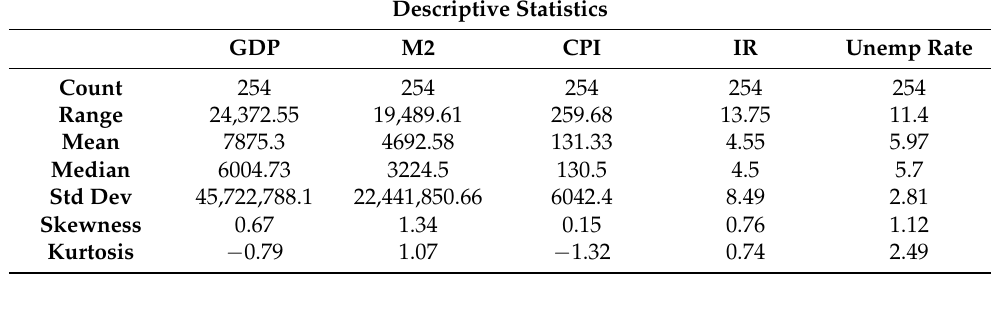
Table 1. Descriptive Statistics.